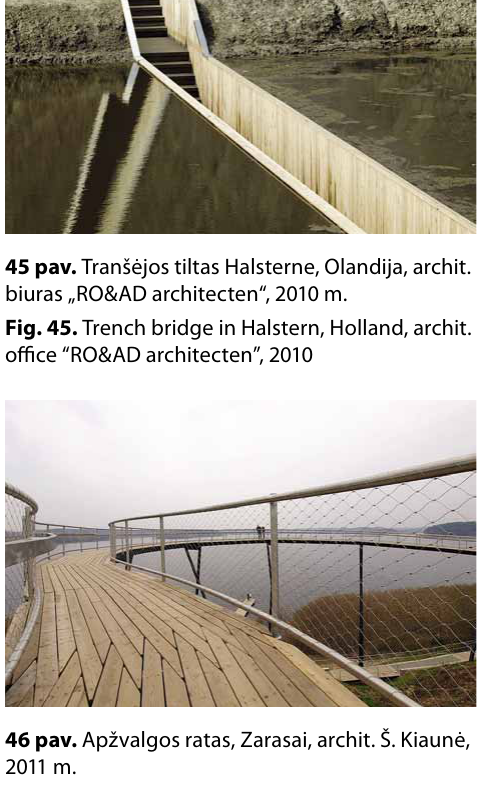
Fig. 46. Observation bridge in Zarasai, archit.